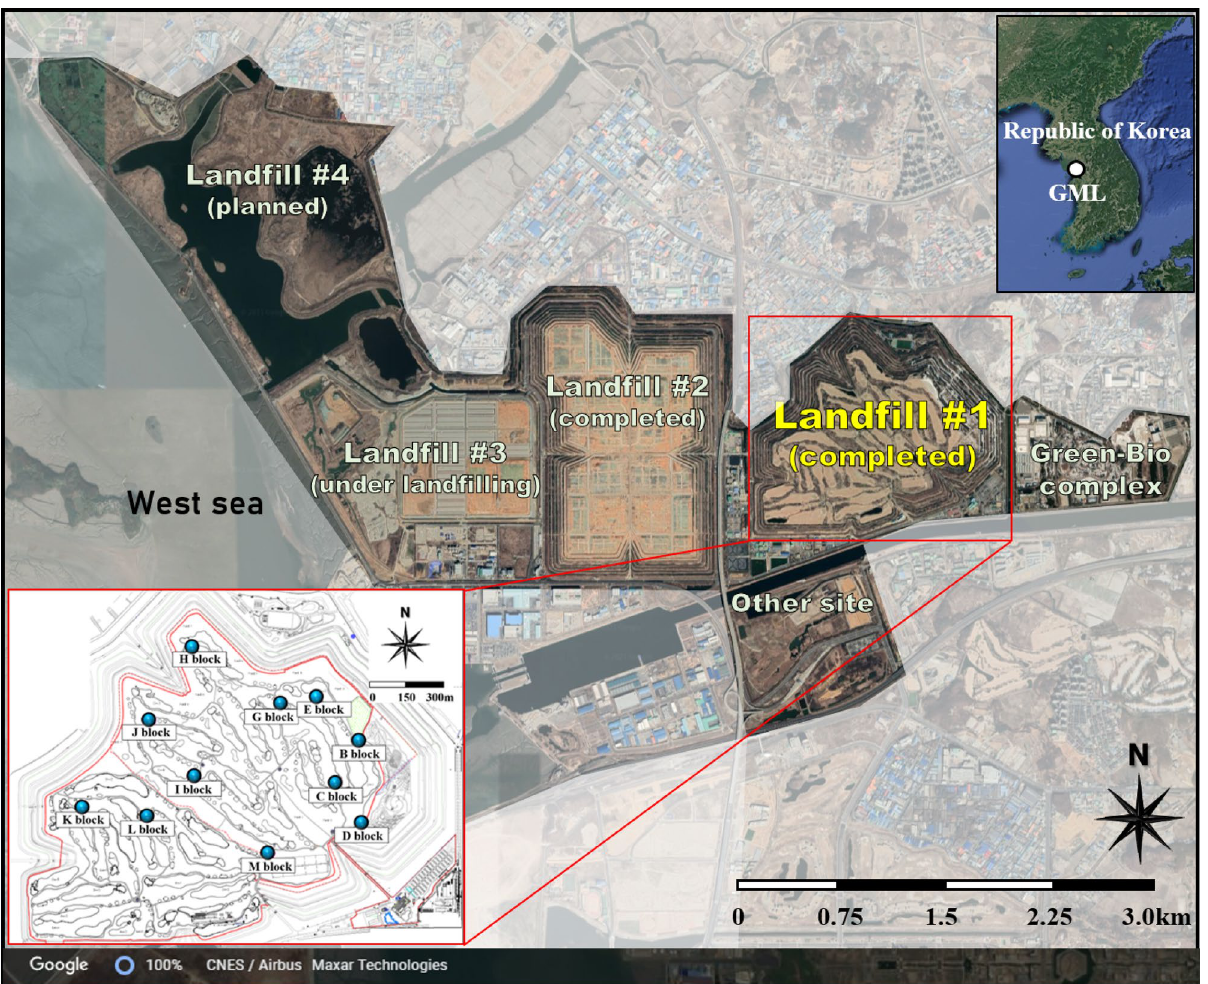
Figure 2. Location of Gimpo Metropolitan Landfill (GML) and landfill #1 where the waste disposal was completed; Layout of the GML and detailed location of each landfill; Location of settlement plates installed on the uppermost layer of landfill #1 after closure (Satellite images were extracted from Google Earth and edited using Microsoft Office’s